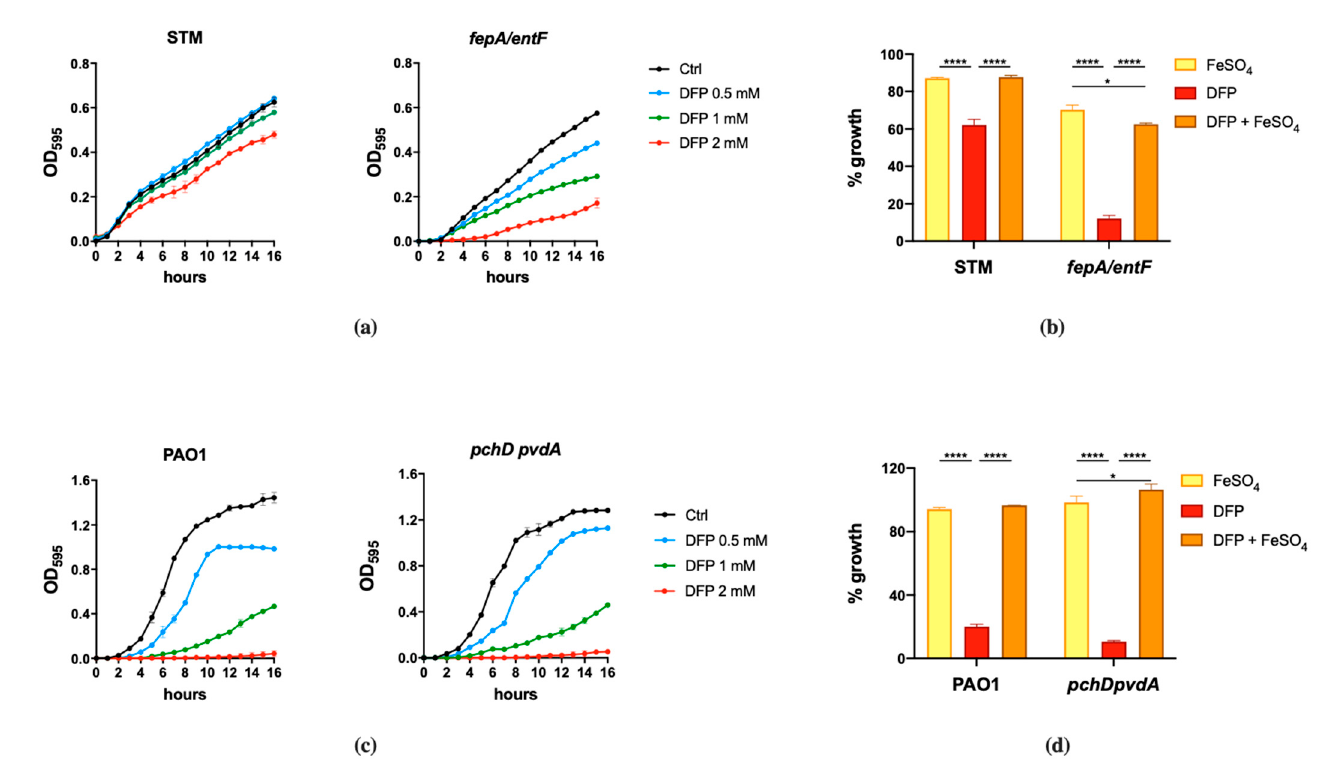
Figure 1. Effect of DFP on STM and PAO1. STM (wild type) and fepA/entF strains ( a ) and PAO1 (wild type) and pchD pvdA strains ( c ) were grown in LB medium with increasing amounts of DFP as indicated. In ( b , d ), the same strains were grown in presence of FeSO 4 (0.5 mM), DFP (2 mM in ( b ) and 1 mM in ( d )) or both, optical densities were measured after 14 h and % of growth were calculated taking the growth of untreated strains as 100%. Statistical significance (two-way ANOVA and Sidak’s multiple comparisons test): * p < 0.05; **** p < 0.0001.